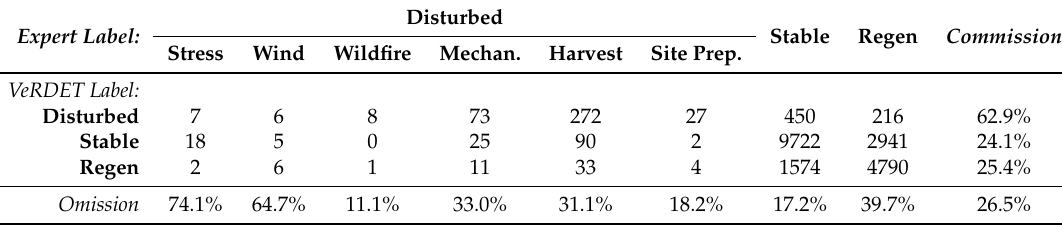
Table 2. Agreement between the VeRDET segmentation and the expert segmentation after snapping VeRDET breakpoints to expert breakpoints given a 1-year